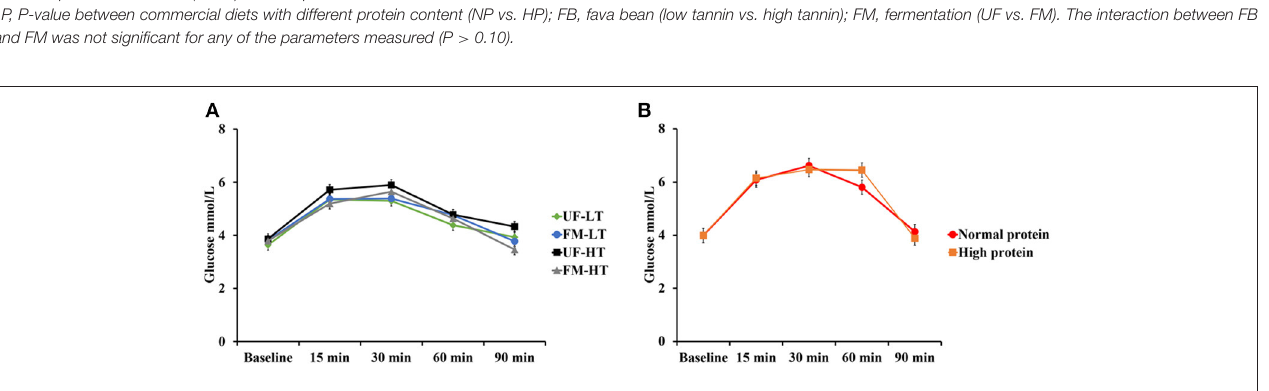
FIGURE 1 | Blood glucose responses to the oral glucose tolerance test in dogs fed either low (LT) or high (HT) tannin fava bean–based diets without (UF) or with (FM) fermentation (A) , or normal vs. high protein commercial diets (B) . Eight mixed-gender, neutered beagles were fed the NP, or HP diets during the first and sixth weeks, respectively. From weeks 2 to 5, using a randomized, crossover, 2 × 2 Latin square design, 4 diets differing in fava bean variety and fermentation were compared as follows: UF-HT, FM-HT, UF-LT, and FM-LT. Fasting and peak glucose levels, time to peak, and area under the curve (AUC) were not influenced by dietary treatments ( P > 0.10).